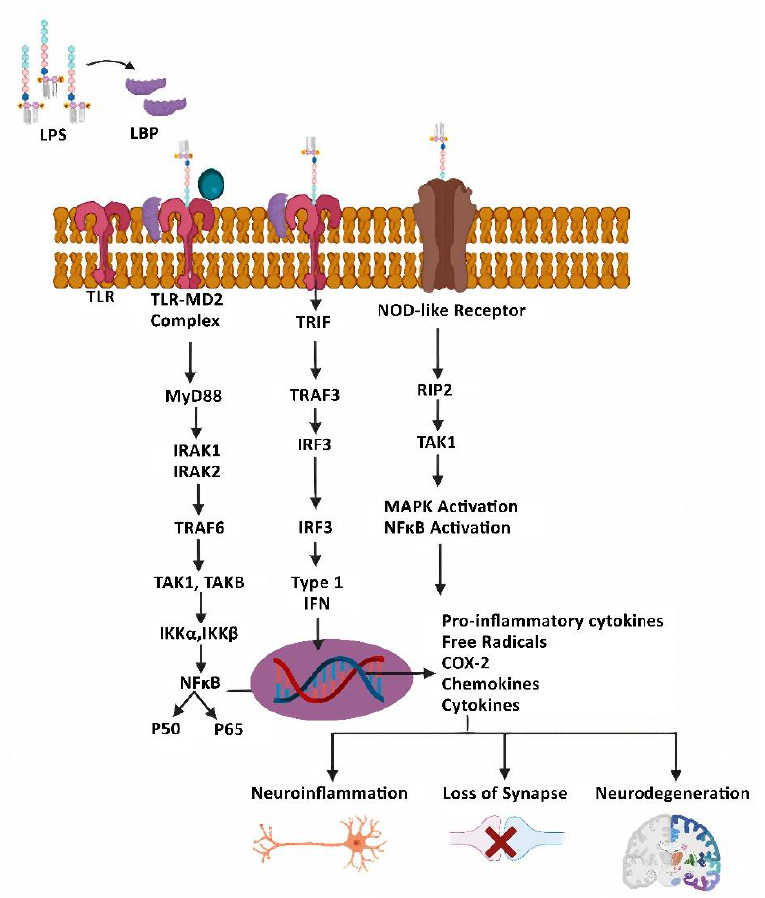
Figure 2. Mechanisms of lipopolysaccharide (LPS-induced neurodegeneration). LPS, with the help of lipopolysaccharide binding (LBP), binds to a different family of receptors viz NOD-like receptors and toll-like receptors (TLRs) to generate TLR-MD2 complex. The downstream signaling cascades include increased production of proinflammatory cytokines, free radicals, and chemokines, all of which contribute to synaptic loss, neuroinflammation, and neurodegeneration.